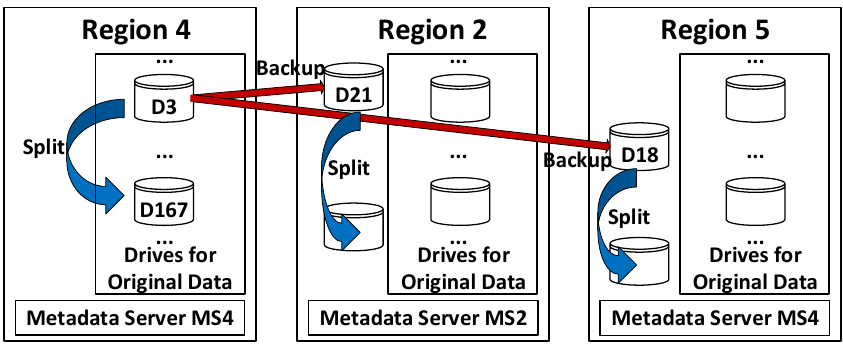
Figure 7. An example of backup and